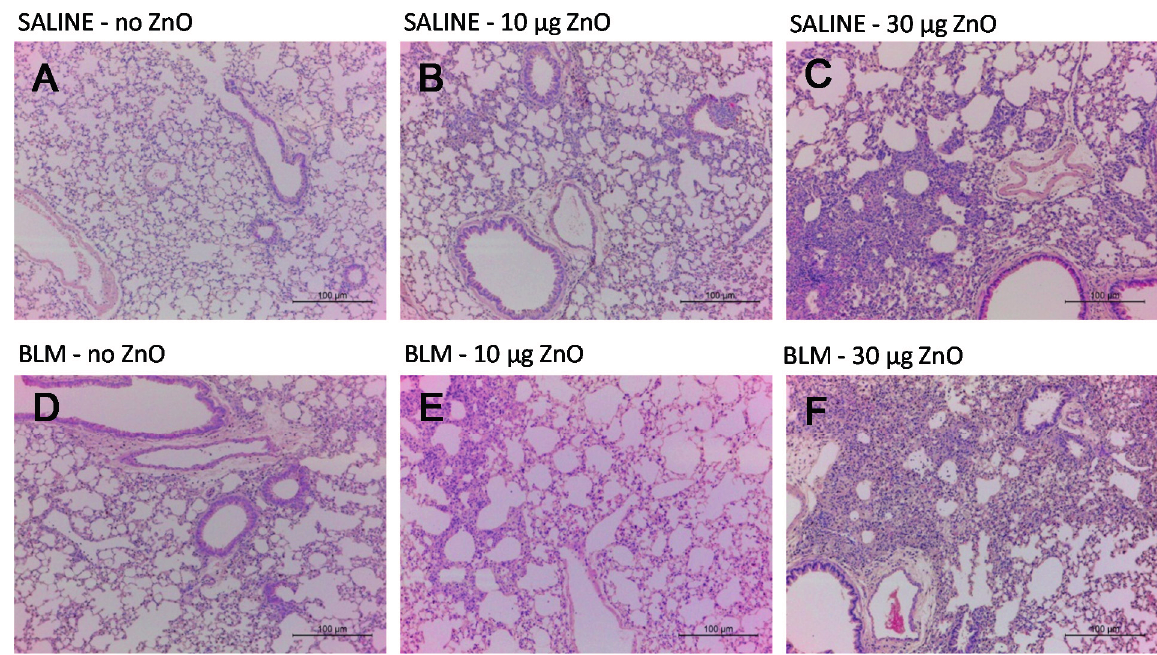
Figure 1. Representative optical micrographs of H&E-stained lung tissues. Mice were exposed to: ( A ) no ZnO; ( B ) 10 µg of ZnO; ( C ) 30 µg of ZnO nanoparticles without BLM treatment; ( D ) no ZnO; ( E ) 10 µg of ZnO; and ( F ) 30 µg of ZnO nanoparticles with BLM treatment. Samples were collected at Day 10 after